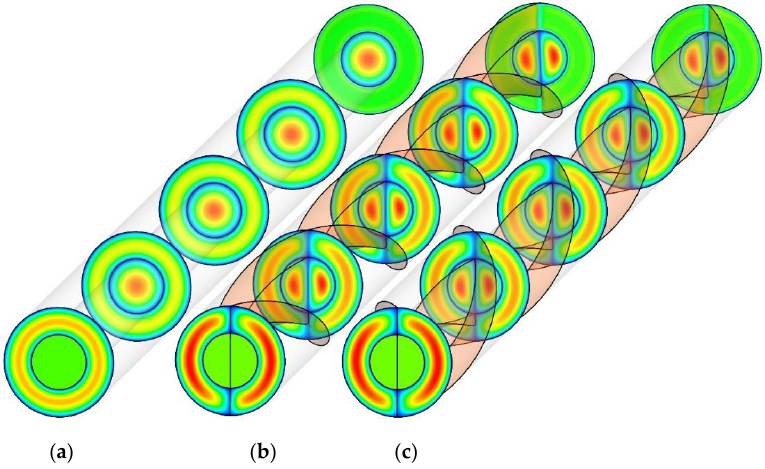
Figure 9. Cross-sectional velocity contours at the Reynolds number of 250 for: ( a ) PHE; ( b ) Co-STT; and ( c ) Counter-STT. and ( c )